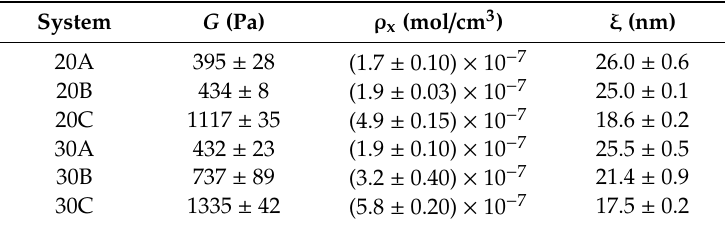
Table 2. Shear modulus ( G ), crosslink density ( ρ x ), and average mesh size ( ξ ) referring to the six hydrogel considered in this